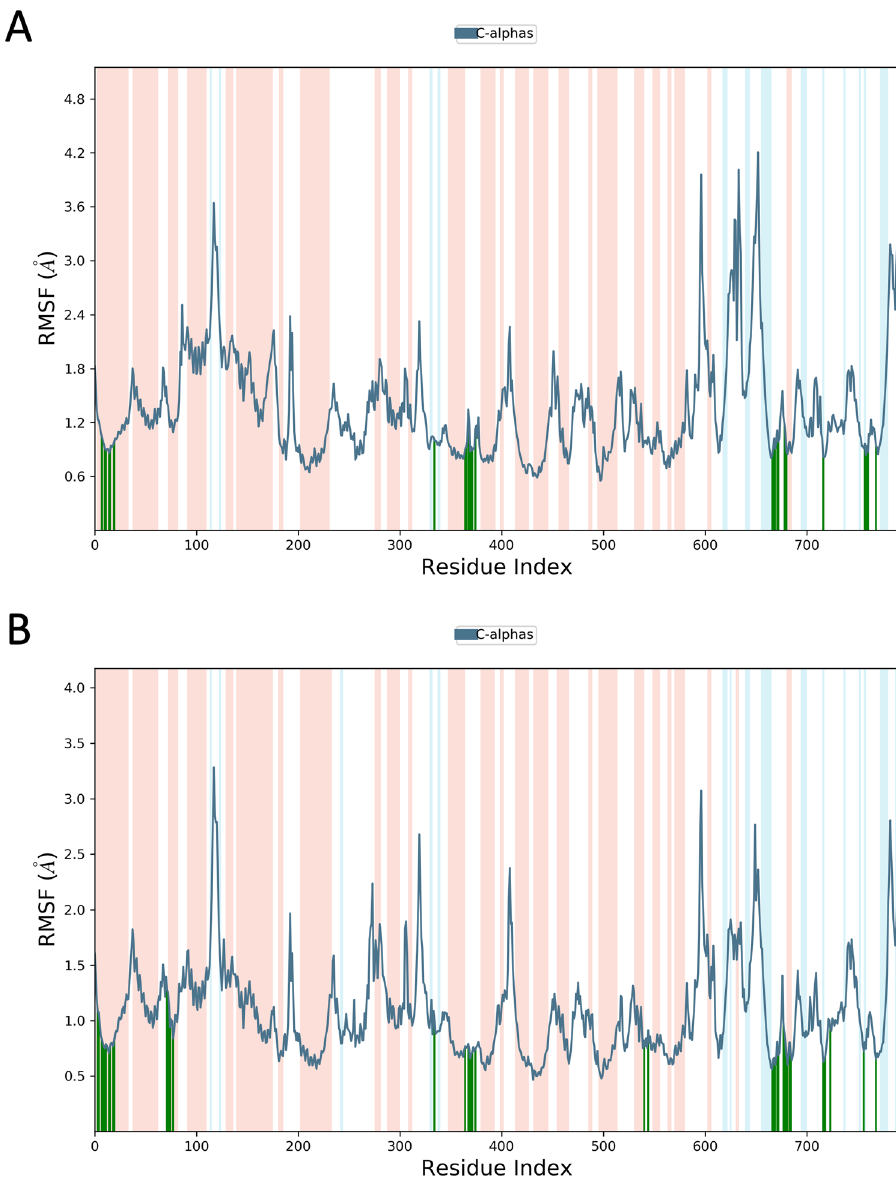
Figure 9. ( A ) RMSF plot depicting curcumin-induced fluctuations in the entire amino acid sequence of RBD/ ACE2-complex during 100 ns MD simulations. ( B ) RMSF plot depicting catechin induced fluctuations in the entire amino acid sequence of RBD/ACE2-complex during 100 ns MD